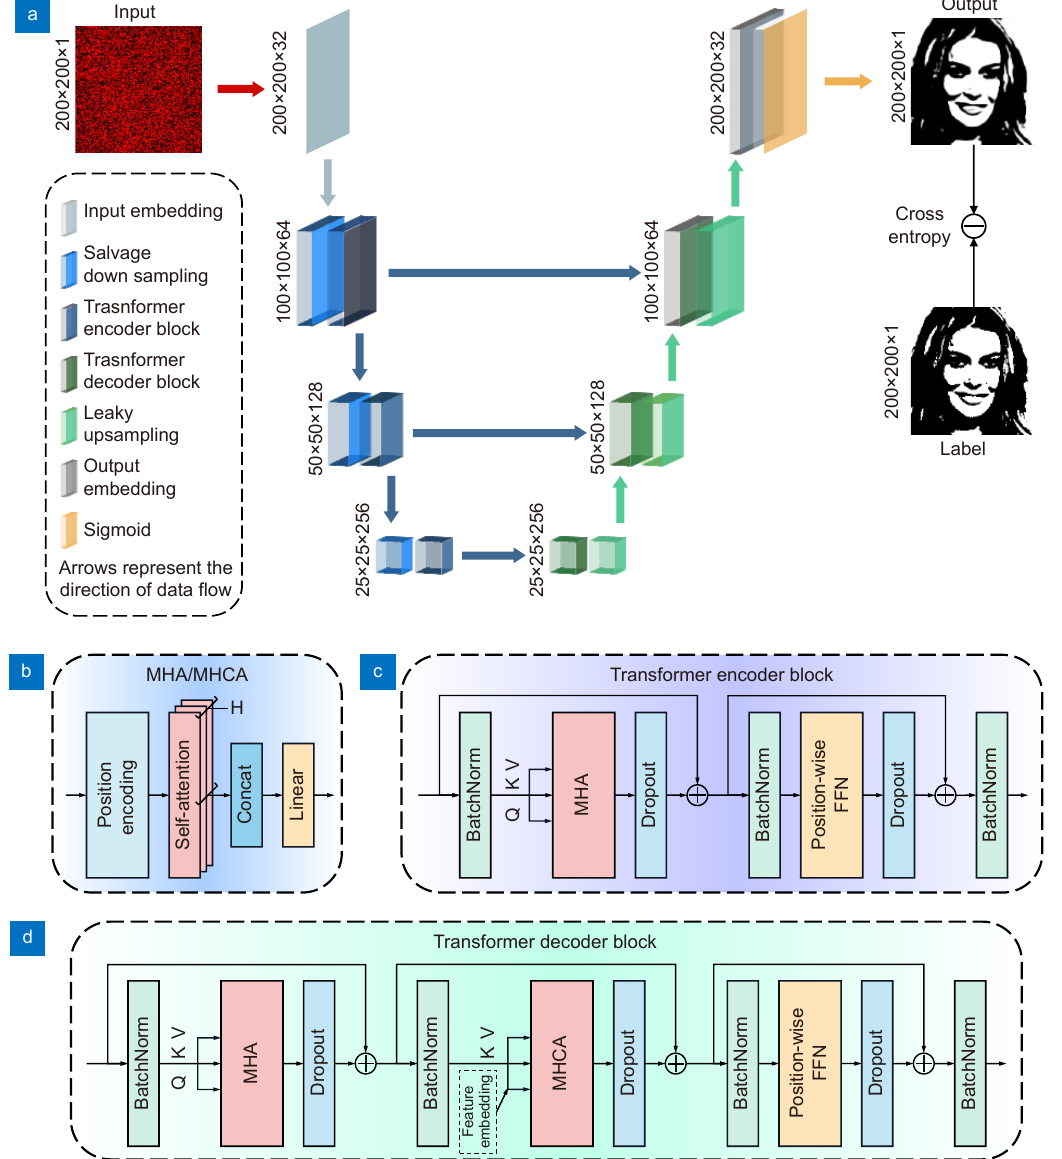
Fig. 1 | SpT UNet architecture for spatially dense feature reconstruction ( a ) with the multi-head attention (or cross attention) module ( b ) included transformer encoder block ( c ) and decoder block ( d